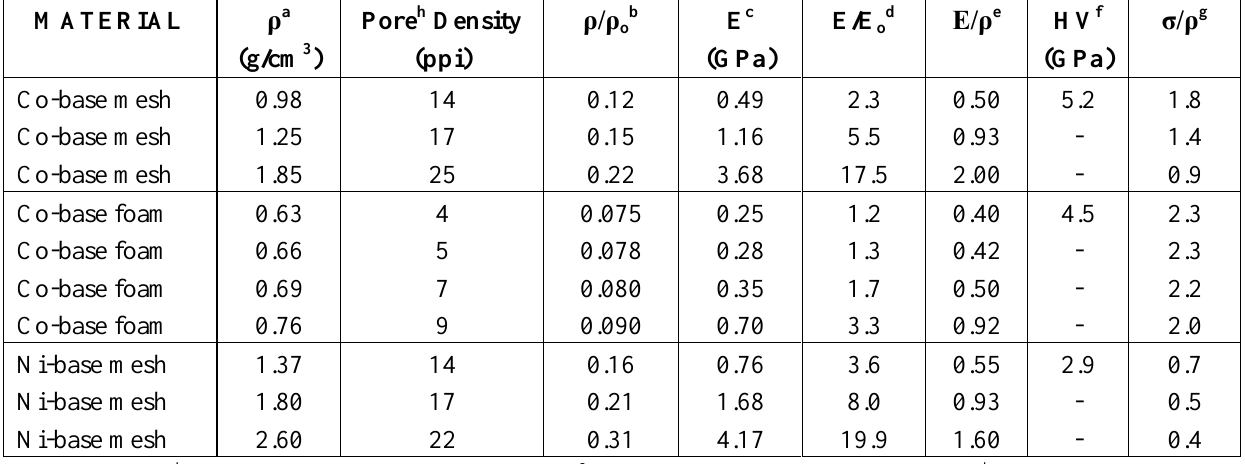
Table 1. Density, Modulus, Hardness Measurements and Related Values for Co-Base and Ni-Base Alloy Mesh and Foam